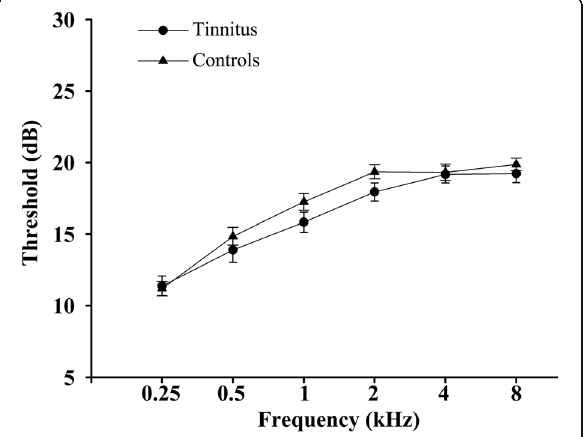
Fig. 1 Mean hearing thresholds of the chronic tinnitus patients and non-tinnitus controls. Data are presented as Mean ±